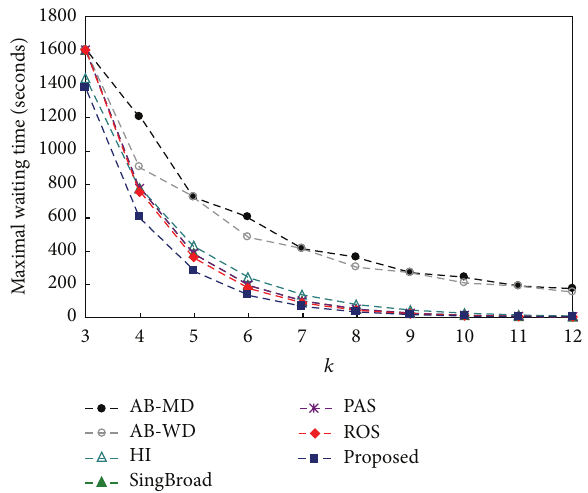
Figure 5: Maximal waiting time yielded by different schemes, where L =120min.